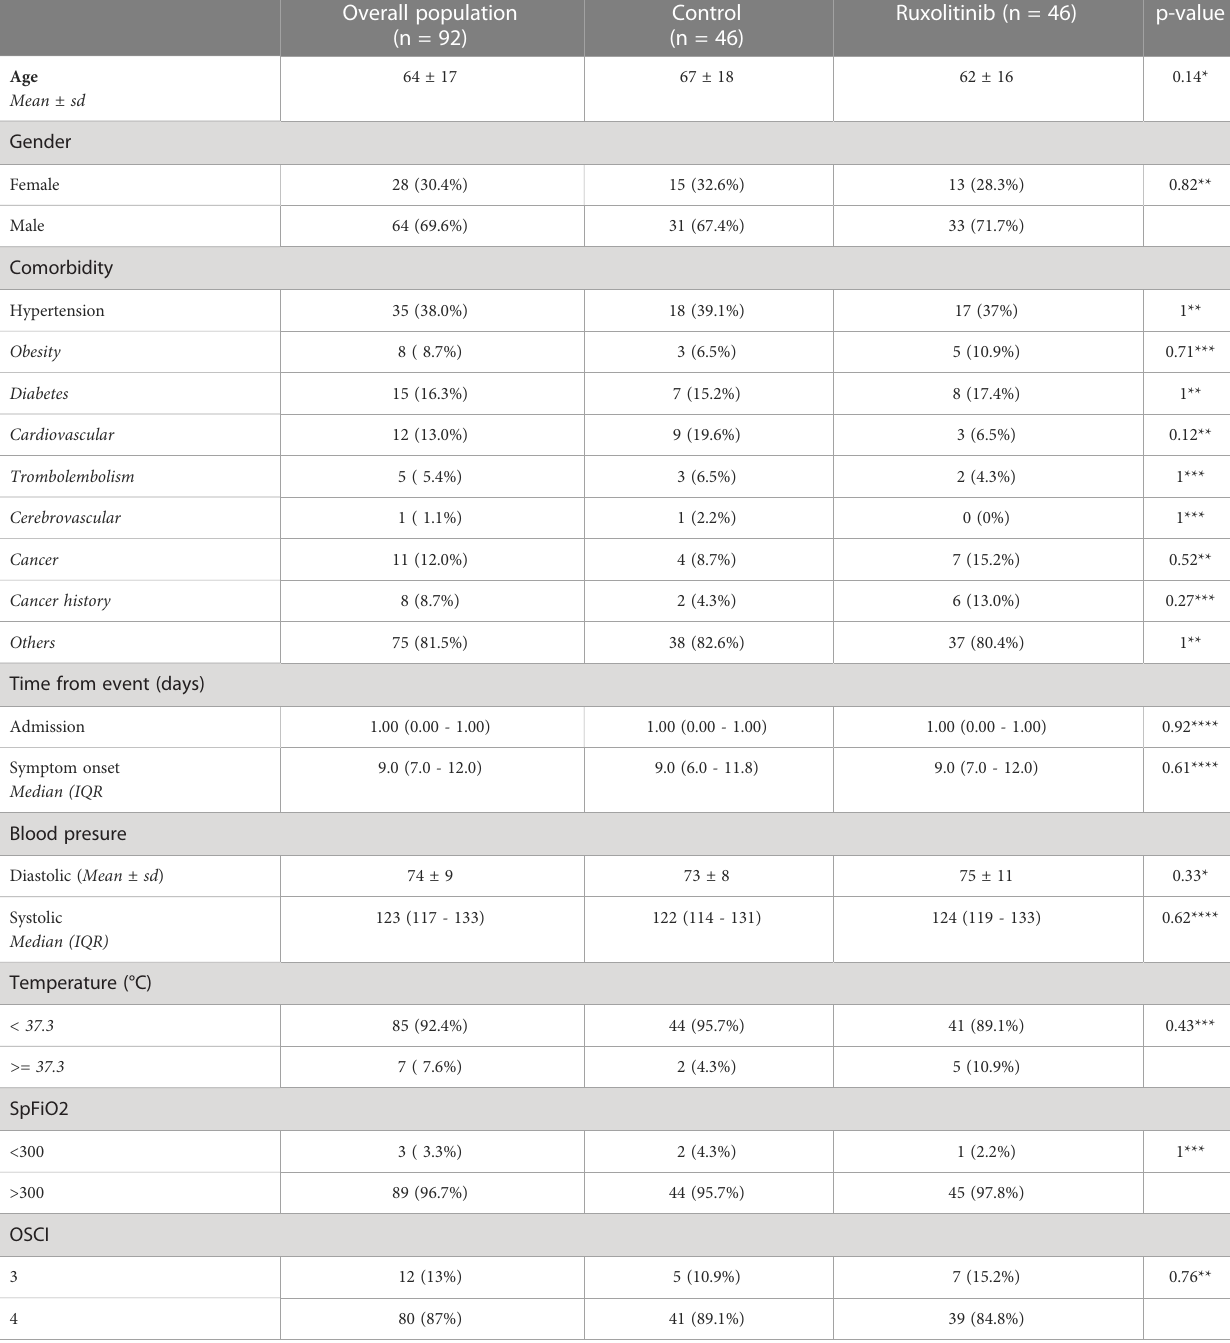
TABLE 1 Demographics and basal clinical